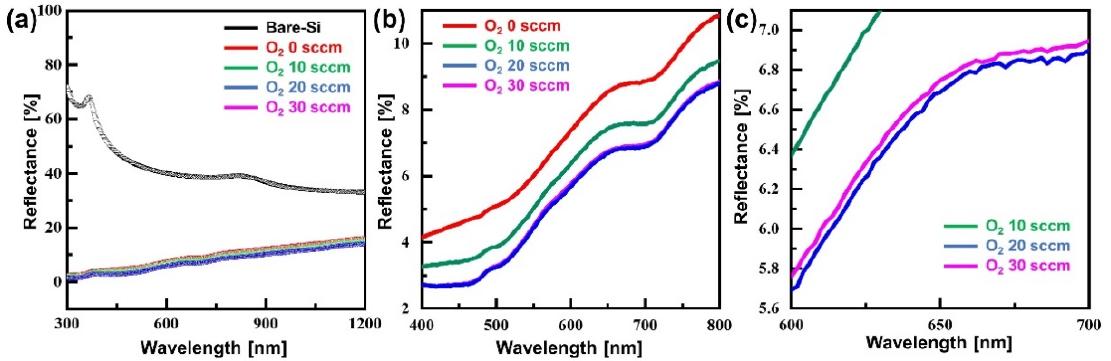
Figure 4. The reflectance spectra of an inverse moth-eye-structured silicon substrate depending on the SF 6 /O 2 gas mixing ratio: ( a ) wavelength of 300–1200 nm, ( b ) magnified at 400–800 nm wavelength, and ( c ) magnified at 600–700 nm wavelength.